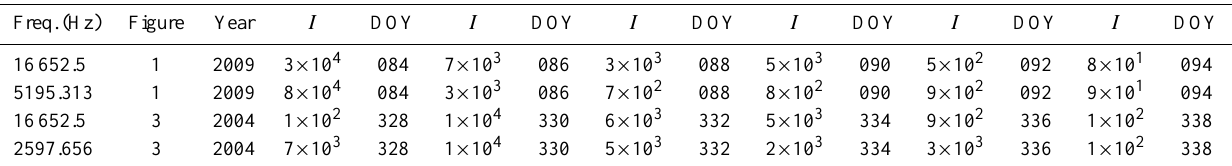
Table 1. Intensity level variations for transmitter signal ( f =16652.5Hz), and natural VLF ionospheric emissions ( f =5195.313Hz) before l’Aquila EQ occurrence.